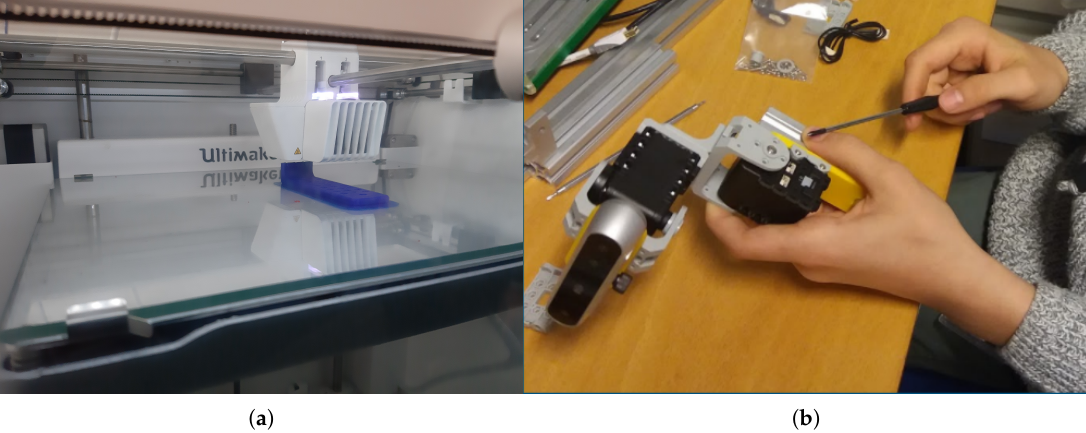
Figure 12. Students assembling their printed tool: The students also learn about how 3D printers work as they print their piece ( a ) printing tools in 3D; ( b ) assembling the tool in the robot to solve the